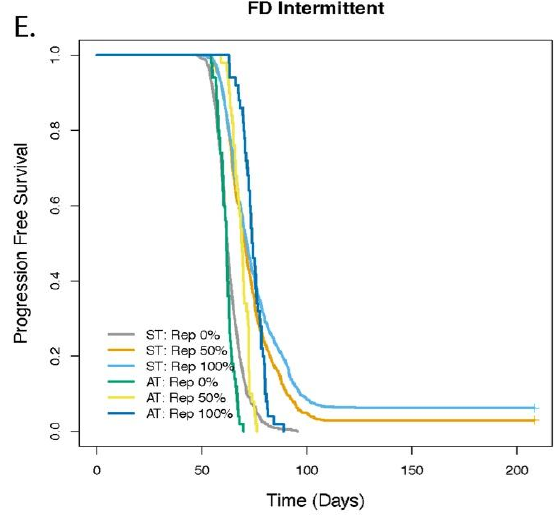
Figure 7. Effect of replacement on outcome of adaptive therapy with 2 drugs. The panels show the comparison of adaptive therapy (AT) versus standard treatment (ST) as the replacement parameter is varied for ( A ) DM Cocktail Tandem, ( B ) DM Ping-Pong Alternate Every Cycle, ( C ) DM Ping-Pong on Progression, ( D ) FD Dose-Skipping/Drug-Holiday, ( E ) FD Intermittent. The replacement parameter determined the probability that a dividing cell with no empty neighbors could replace a neighbor. We tested the two extremes in which a cell can always replace a neighbor (Rep 100%), representing direct cell competition, cancer cell cannibalism, or cell death due to crowding. We represented complete contact inhibition when a cell can never replace a neighbor (Rep 0%). We also tested an intermediate value (our default) in which a dividing cell can replace its neighbor 50% of the time (Rep 50%), representing some cell death due to crowding and other forms of competition, but also some degree of contact